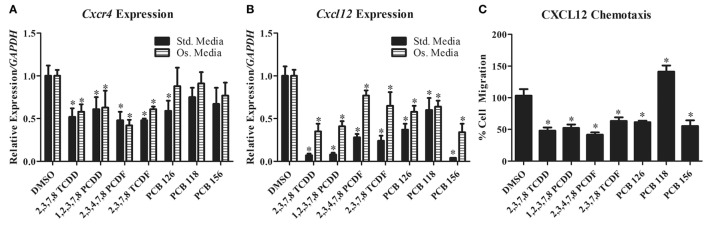
(A,B)
Cxcr4 and Cxcl12 gene expression changes in primary rat BMSC grown in either standard or osteogenic media and treated with TCDD and dioxin-like compounds. (C) Chemotaxis rate of BMSC (toward 200 ng/mL of recombinant CXCL12) pretreated with TCDD and dioxin-like compounds. *p < 0.05 relative to DMSO vehicle control-treated cells. 2,3,7,8-TCDD, 2,3,7,8-tetrachlorodibenzo-p-dioxin; 1,2,3,7,8-PCDD, 1,2,3,7,8-pentachlorodibenzo-p-dioxin; 2,3,4,7,8-PCDD, 2,3,4,7,8-petachlorodibenzofuran; 2,3,7,8-TCDF, 2,3,7,8-tetrachlorodibenzofuran; PCB-126, 3,3′,4,4′,5-pentachlorobiphenyl; PCB-118, 2,3′,4,4′,5-pentachlorociphenyl; PCB-156, 2,3,3′,4,4′,5-hexachlorobiphenyl.